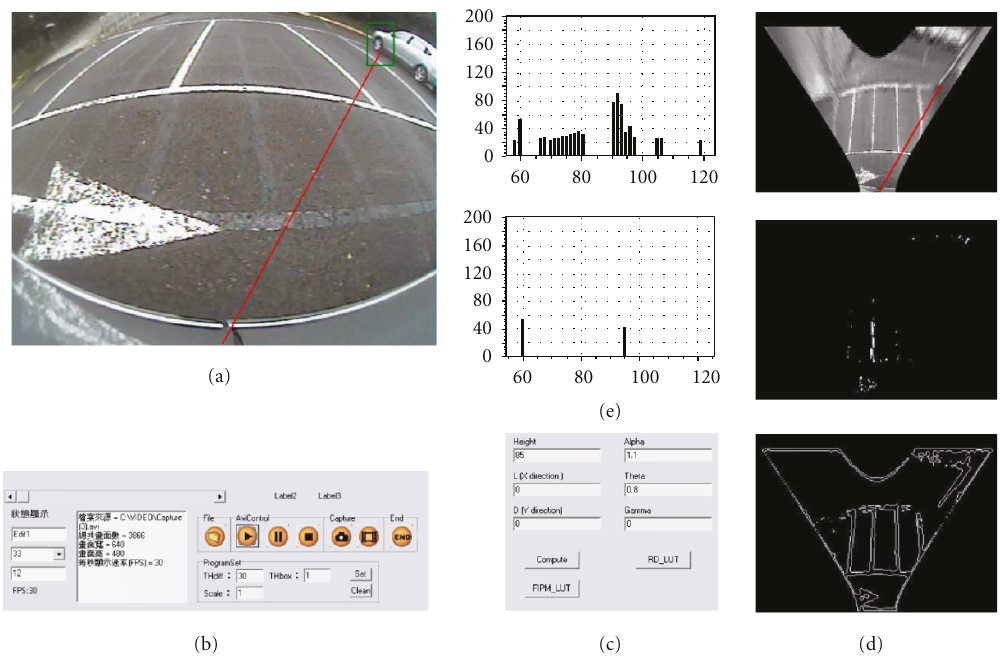
Figure 21: The interface of our program and the related information about adjustable